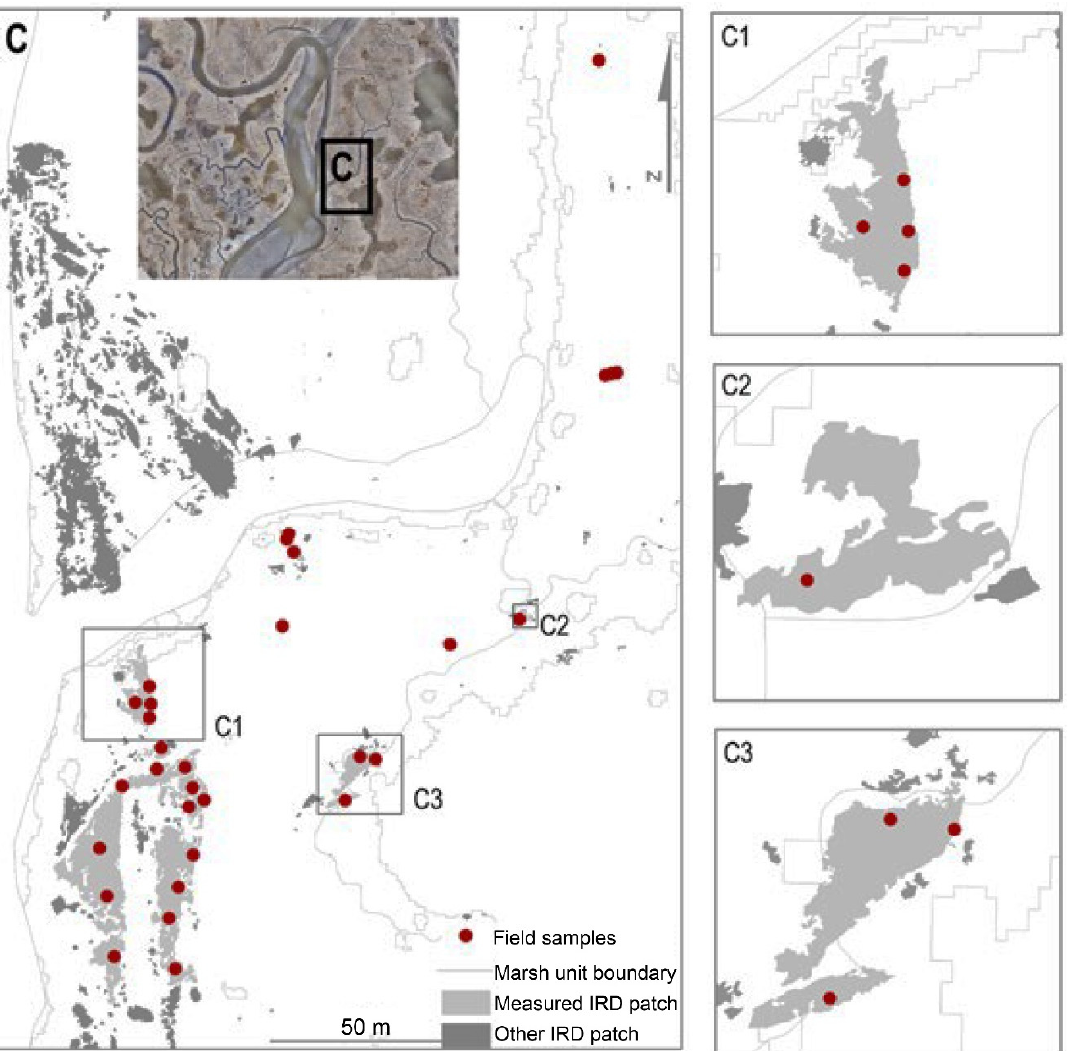
Figure 6. IRD patches that were measured in the field and identified in the classified map. The red circles show the points at which thickness was measured. The dark grey patches were identified by the map but not measured. The light grey patches were identified by the map and measured. The grey lines show the boundaries of conceptual marsh units based on tidesheds in Plum Island [30].